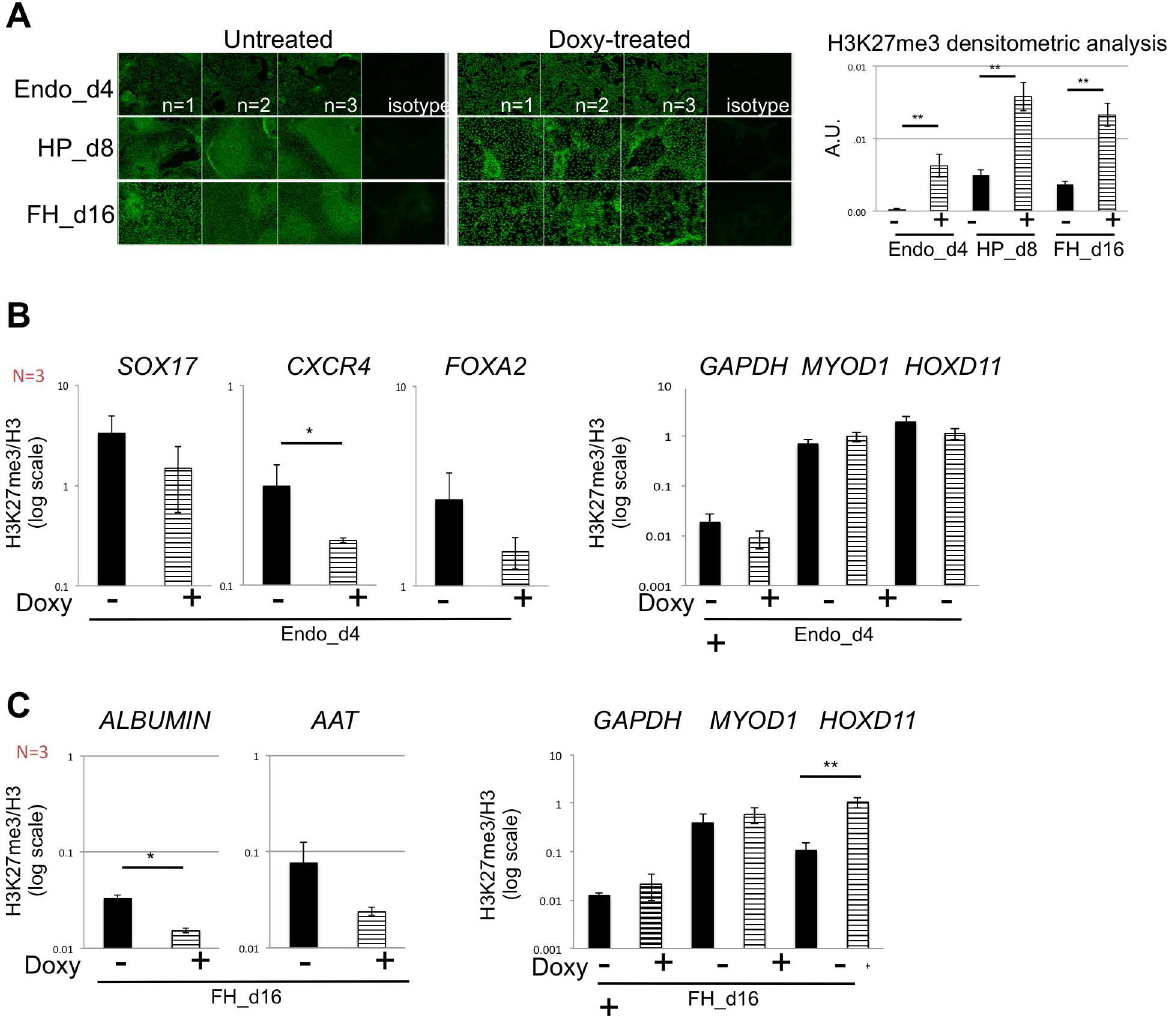
Fig 4. Total H3 levels and H3K27me3levels on endodermal and hepatocyte genes. A. Left, representative immunofluorescence imagefor H3K27me3(greensignal)of threedifferentdifferentiations(n = 1, 2 and3) at endo_d4,HP_d8andFH_d16stagesin untreated anddoxy-treated cells.Right, the fluorescence of H3K27me3signalwas digitallyquantified(additionaldetailsin the Supplemental Information). Resultsrepresentthe meanof threeindependent experiments ± SEM anddisplayedas arbitraryunits(A.U.). ** p < 0.01. B. Histonemodificationlevelsof H3K27me3at SOX17, CXCR4andFOXA2 (left part) andGAPDH, MYOD1andHOXD11promoter(right part)at endo_d4inuntreatedanddoxy-treatedcells. Resultsrepresentthe meanof three independent experiments ± SEM. * p < 0.05. C. Histonemodificationlevelsof H3K27me3at ALBUMINandAAT (left part)andGAPDH,MYOD1 andHOXD11promoter (right part) at FH_d16in untreated anddoxy-treated cells.Resultsrepresentthe meanof threeindependent experiments ± SEM. * p < 0.05, ** p <